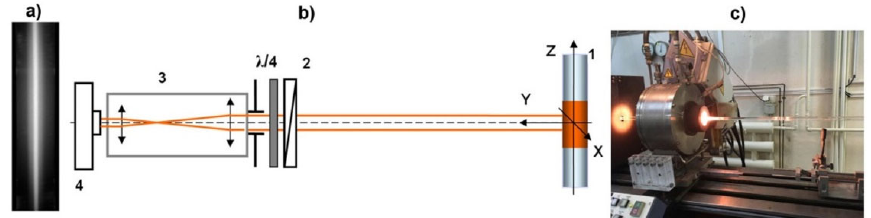
Figure 1. ( a ) The captured image of the heated part of the preform; ( b ) experimental setup (schematic view from the top). In the diagram, the numbered elements are as follows: the preform (1) is located along the horizontal axis Z, the polarizer (2) and λ /4 plate are placed in front of the telescope (3), and the image is formed on the matrix of the camera (4); ( c ) The main view of the FCVD lathe with heated